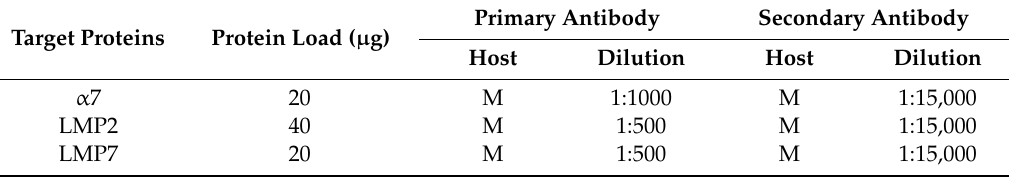
Table 1. Antibodies used for